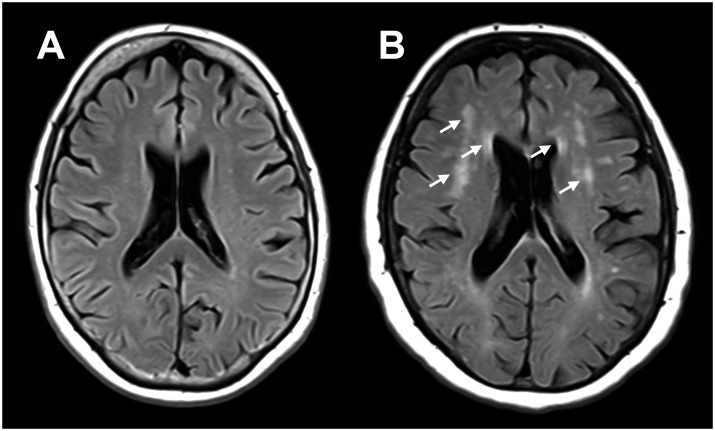
FLAIR images of two different representative subjects with different WMH load.Subject A represents lower WMH load (i.e. a WMH volume ≤ 0.5% of the intracranial volume that corresponded approximately to Fazekas grade 0–1) and subject B higher WMH load (i.e. a WMH volume ≥ 1% of the intracranial volume that corresponded approximately to Fazekas grade 2–3), with arrows indicating example regions with WMH.